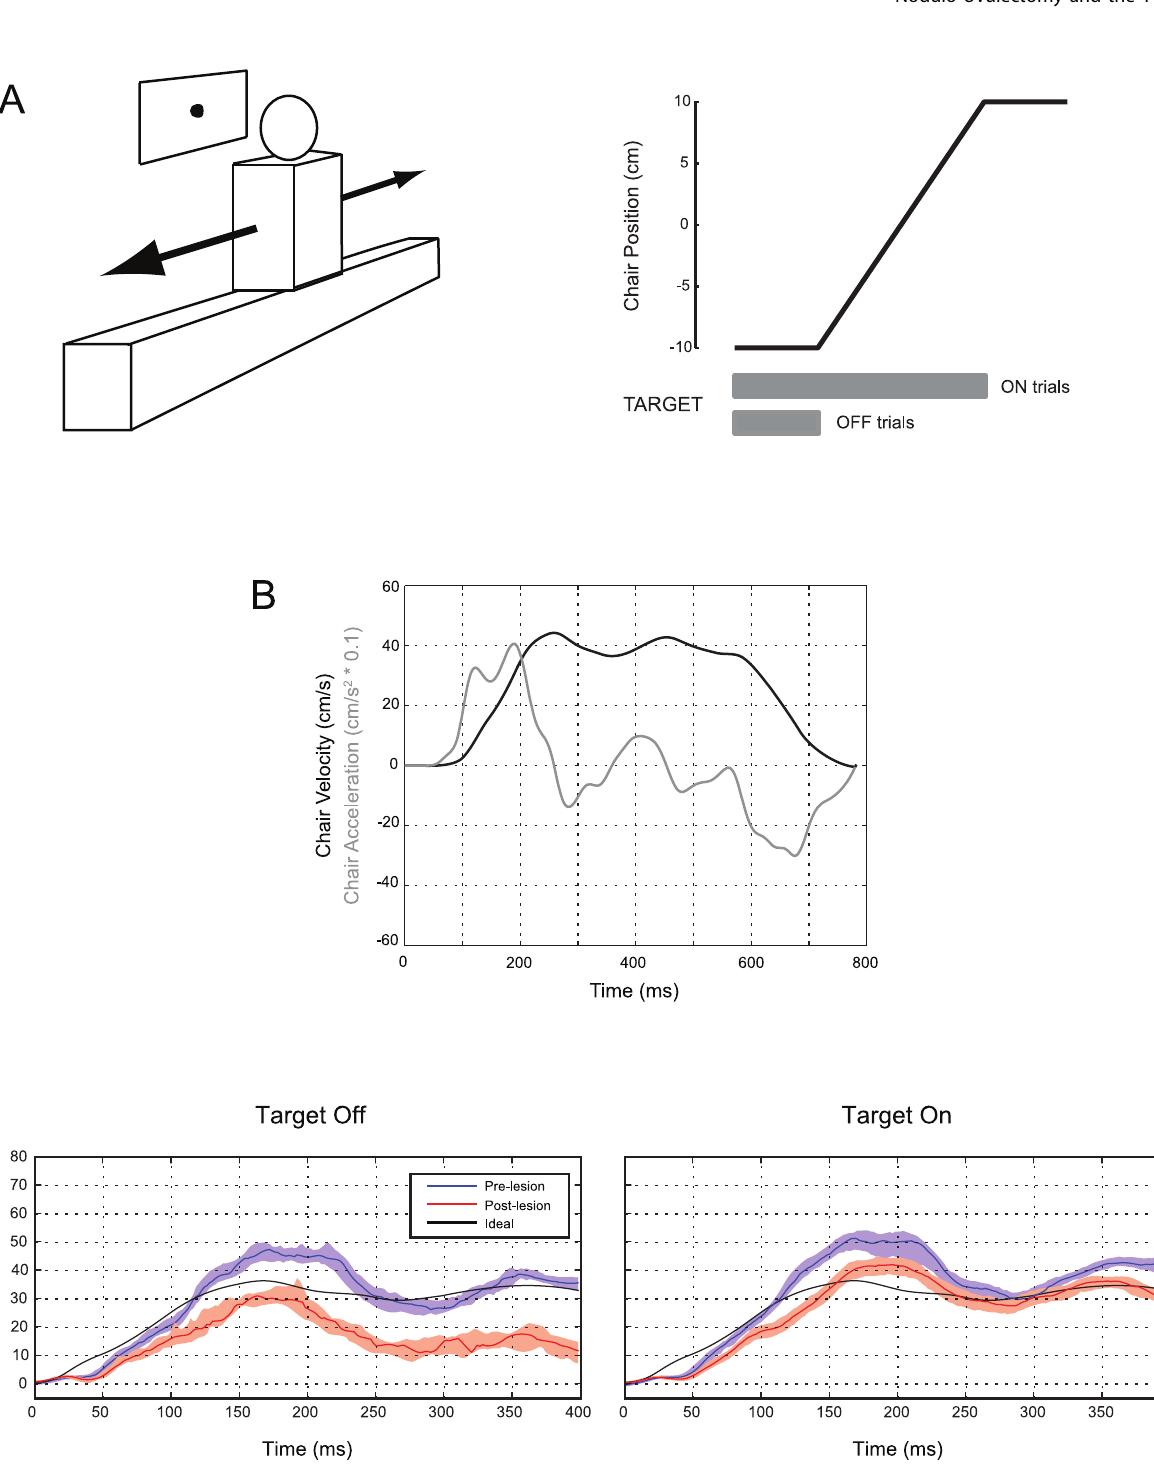
Figure 1. a. Schematic diagram of experimental setup (left) and a single motion trial (right). The monkey sat in a primate chair, facing a translucent screen on which was projected a laser target. The chair was translated along the interaural axis by a belt-driven motor. Each trial began with the monkey fixating the visual target located directly in front of its eyes. Then, the chair was translated at constant speed over a distance of 20 cm. For half of the trials, the target went out when the chair started to move; for the remainder, the target remained illuminated. After the chair stopped, the target was moved 20 cm, across from the new chair location, and the monkey fixated the target, starting a new trial. The chair moved back to the original position. b . Representative chair velocity and acceleration profiles (based on chair velocity feedback) for a single translation. Chair acceleration is scaled down by a factor of 10. c . Responses to rightward translation in animal M2, before and after lesioning of the Nod/Uv. The viewing distance is 70 cm. The solid colored lines indicate the median velocity across all trials (first 400 ms), excluding quick phases and saccades, and the shaded areas include the 25 th to 75 th velocity percentiles. Left panels show the responses when the target went off at the onset of chair movement, and right panels show the responses when the target remained on. The black line is the ideal eye velocity for this viewing distance. Data are plotted according to the right-hand-rule convention: leftward velocities are positive. doi:10.1371/journal.pone.0013981.g001 PLoS ONE |